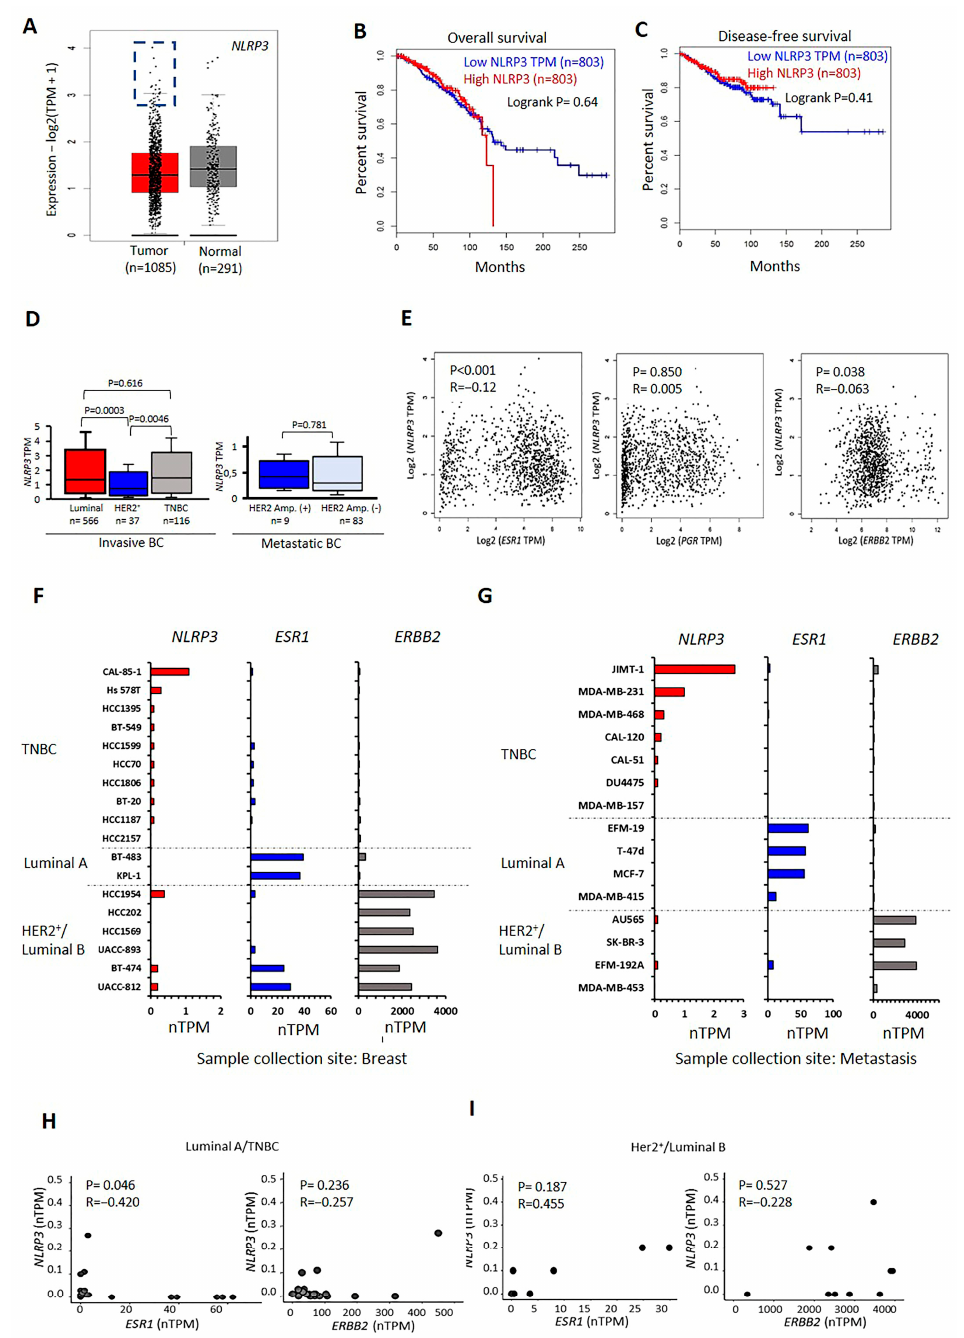
Figure 1. The expression of NLRP3 in BC tumors and the representative BC cell type-specific expressed NLRP3 transcripts. ( A ) The comparison of NLRP3 transcript levels between BC tumors and normal tissues (GEPIA; n = 1376). ( B ) NLRP3 dependent overall and ( C ) disease-free survival of BC patients (GEPIA, n = 1606). ( D ) NLRP3 expression in major subclasses of BC (UALCAN; n = 811). ( E ) The correlation between NLRP3, ESR1, PGR, and ERBB2 in BC tumors (GEPIA, n = 1067). ( F ) The transcript levels NLRP3, ESR1, PGR, and ERBB2 in BC cells from the primary tumor site and ( G ) the metastasis site (HPA). Cells were manually selected from HPA. Cell lines with BRCA1 mutations or controversial molecular classifications were excluded [34,35]. ( H ) The correlation between NLRP3 and ESR1 and ERBB2 in luminal A and TNBC cell lines and ( I ) HER2 + and luminal B cell lines. Luminal A: ER- α + , PR + ; luminal B: ER- α + , HER2 + ; TNBC: triple-negative. TPM: transcripts per million; nTPM: normalized transcripts per